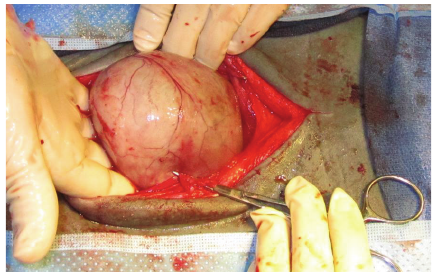
Figure 2: Fluid filled, multiloculated cyst originating from the right liver lobe.